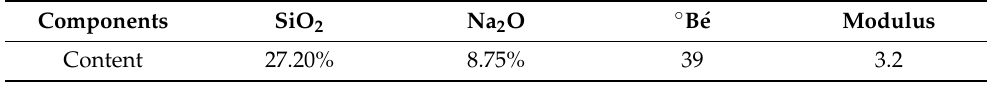
Table 3. Composition of sodium silicate.